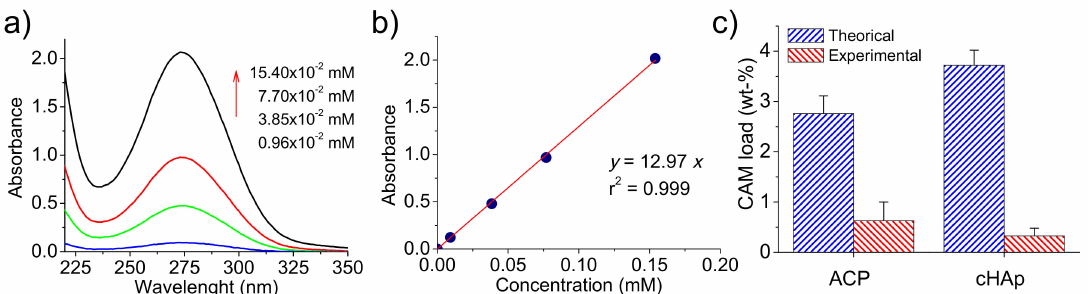
Figure 4. ( a ) UV–spectra of CAM solutions at the indicated concentrations. The spectra showed the absorption band of the p -nitrophenyl chromophore. ( b ) Calibration curve for absorbance measurements at 278 nm in PBS-EtOH medium. ( c ) Encapsulation e ffi ciency for ACP and cHAp